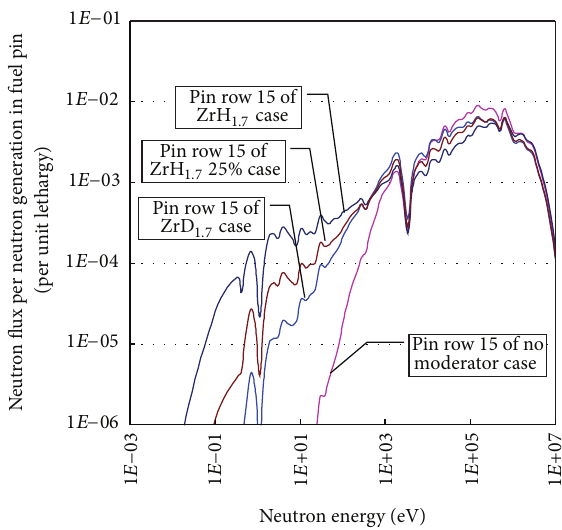
Figure 6: Neutron spectra of outer row pins of outer core 2nd row fuel assembly.